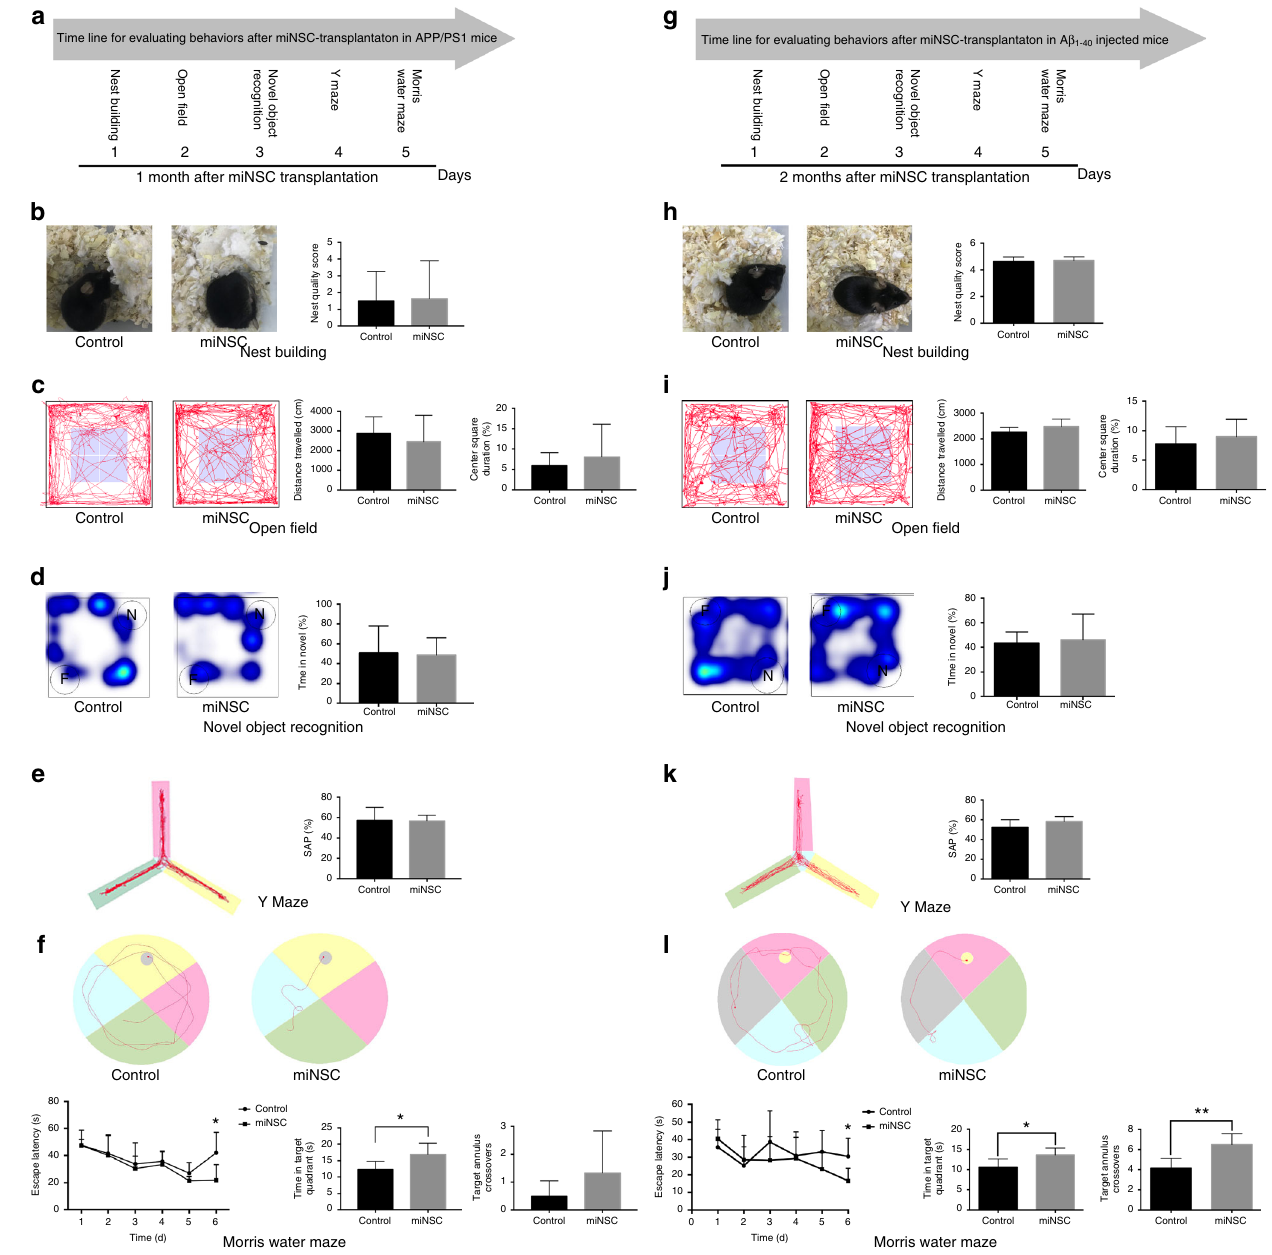
Fig. 6 miNSC transplantation in the hippocampus improved the cognitive dysfunction of APP/PS1 and A β 1-40 -injured mice. a Time table of evaluating the behaviors of APP/PS1 mice after miNSC transplantation. The order for behavioral tests is nest-building, open- fi eld test, novel object recognition, Y-maze test, and Morris water maze test. b Nest-building test. The nest-building behavior of control and miNSC-transplanted mice was assayed by assessing the nest quality after 24 h exposure to a sheet of tissue cotton. Comparing the nest quality, no statistically signi fi cant difference was observed between groups. c Open- fi eld test. An illustrative example of travel pathways for a saline-injected mouse and a miNSC-transplanted mouse in the open- fi eld test. Distance traveled and center square duration in the open- fi eld test show no difference between the groups. d Novel object recognition test. An illustrative example of travel hotspot maps for a saline-injected mouse and a miNSC-transplanted mouse in the novel object recognition test. miNSC-transplanted mice show no difference in the preference for the novel. e Y-maze test. An illustrative example of travel pathways for a saline-injected mouse and a miNSC- transplanted mouse in the Y-maze test. Spontaneous alternation (SAP) in the Y-maze was unimproved for the miNSC-transplanted mice. f Morris water maze test. An illustrative example of travel pathways for a saline-injected mouse and a miNSC-transplanted mouse in the Morris water maze test. Learning curves for Morris water maze acquisition trials were obtained across a period of 6 days. Time spent in target quadrant in the Morris water maze shows that miNSC-transplanted mice spent more time in the target quadrant. Target annulus crossovers reveal that miNSC-transplanted mice show a preference for the target platform location without reaching statistical signi fi cance. g – l As in a – f , but tested after miNSC transplantation in A β 1-40 -injured mice. Data are presented as mean ± SD ( n = 6 – 11). Asterisks indicate signi fi cance in ANOVA test: * p < 0.05, ** p <